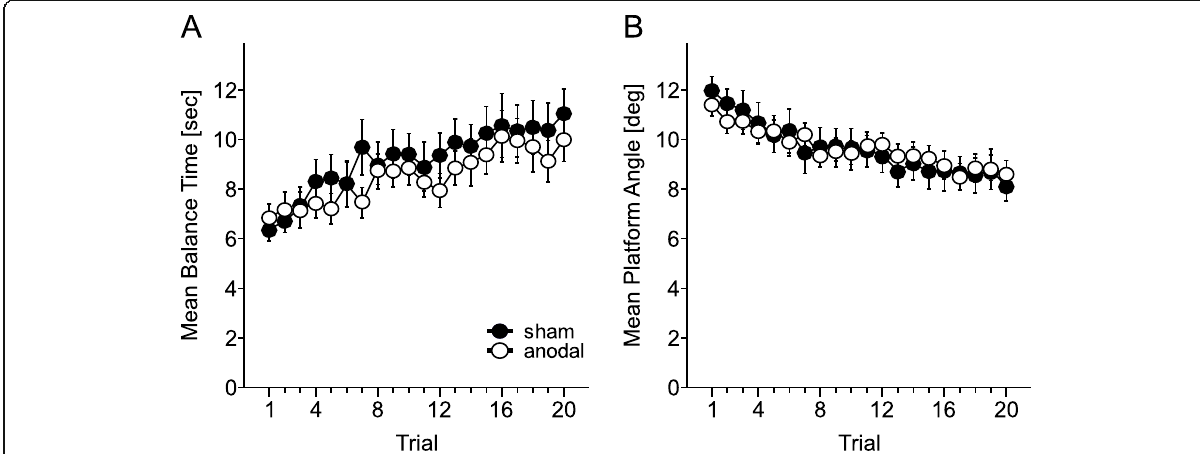
Fig. 4 Mean balance time and standard error of the mean ( a ), and mean platform angle and standard error of the mean ( b ) across the 20 learning trials. Black: sham group, white: anodal